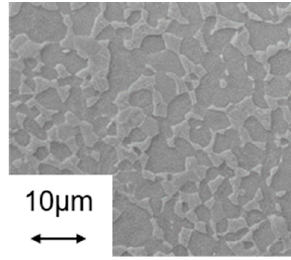
Figure 1. Scanning electron microscopy (SEM) image of the initial microstructure.